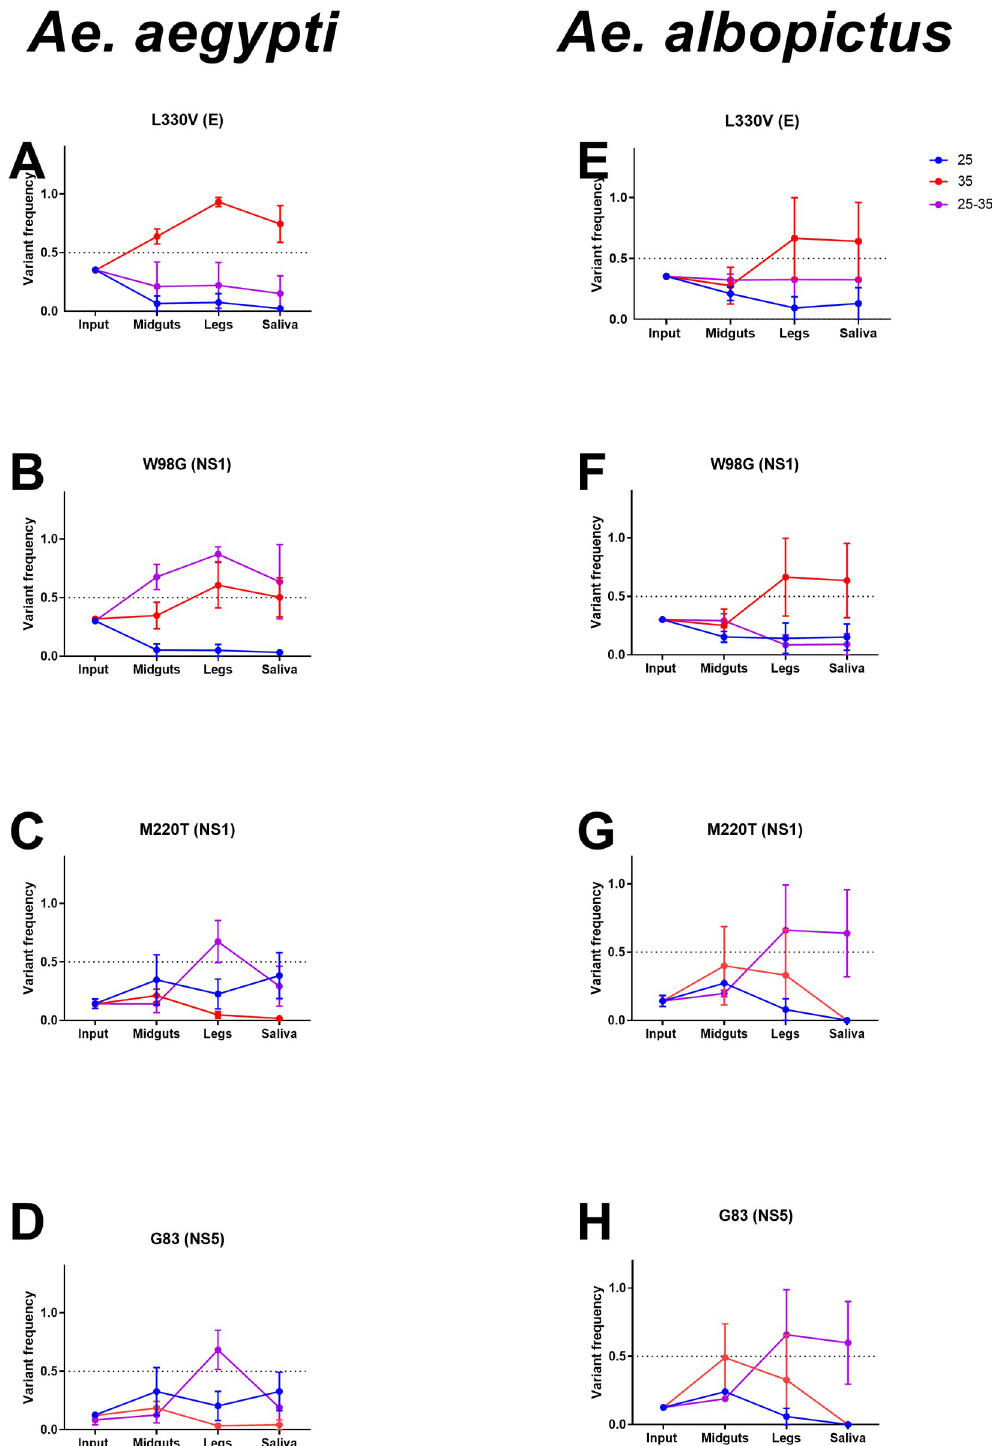
Fig 4. EIT and species control ZIKV variant frequency during systemic infection. Frequencies of L330V E (A & E), W98G NS1 (B & F), M220T NS1 (C & G), and G83 NS5 (D & H) in input, midgut, legs and saliva shown at 25, 35 and fluctuating 25–35˚C in Ae . aegypti (A-D) and Ae . albopictus (E-H). Mean and SEM of competitions from three biological replicates shown.